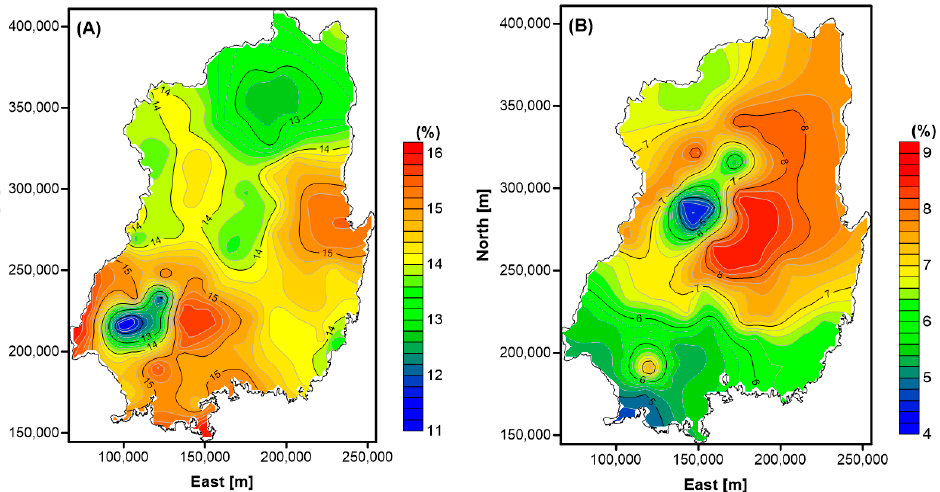
Figure 8. The NGRR (%) relative to the corresponding year from the water budget analysis and RCP 4.5 and 8.5 scenarios from 2009 until 2018.